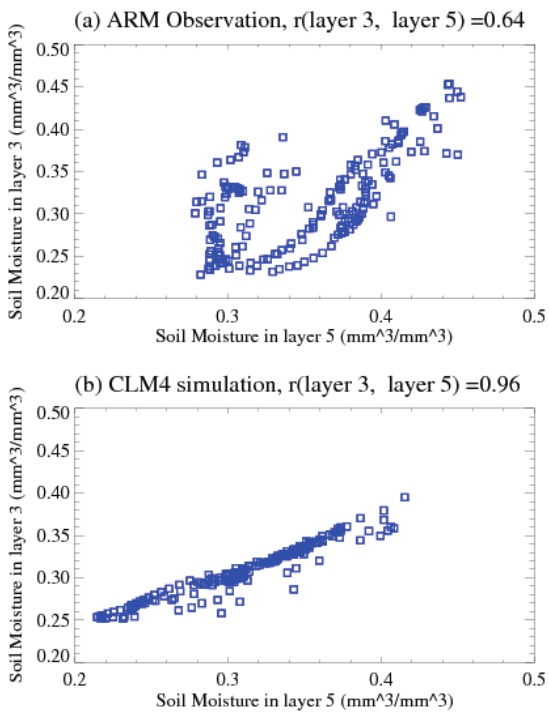
Figure 7. Correlation of volumetric soil moisture between the upper and lower layers: ( a ) is the ARM observations and ( b ) is the CLM simulations. Data is daily average for year 2004.